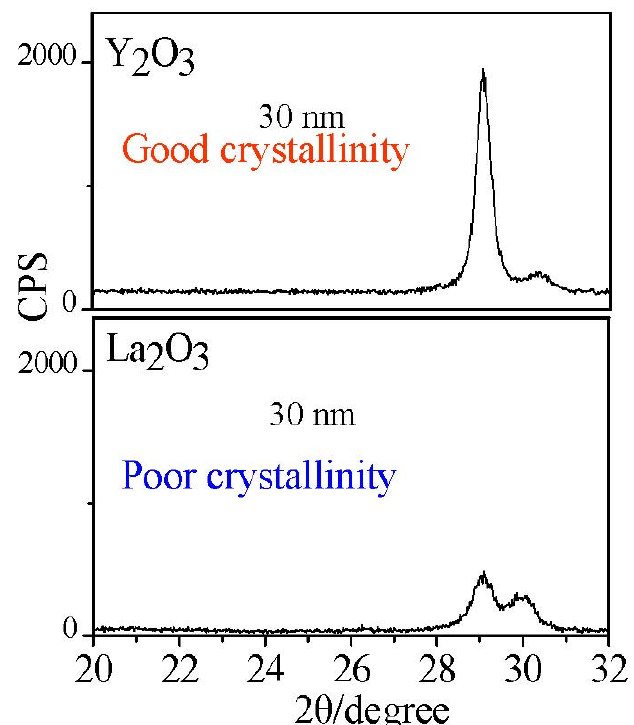
O and La O 2 3 2 3